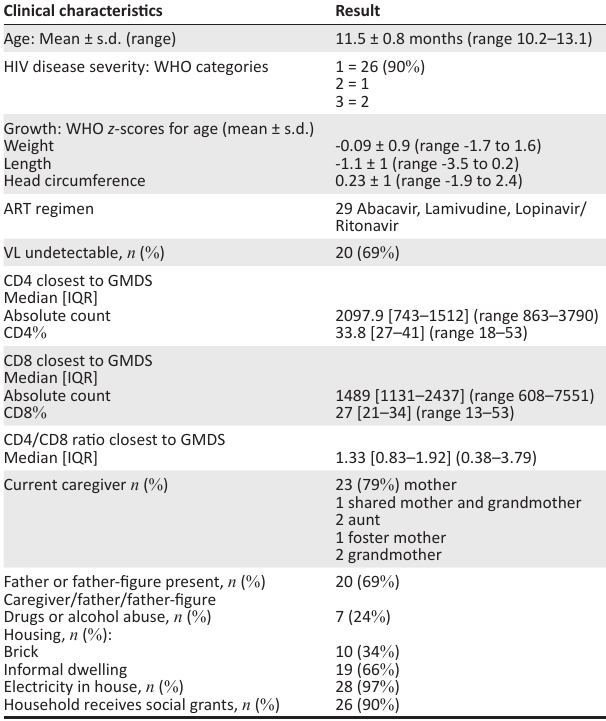
TABLE 3: Clinical status at the time of neurodevelopmental assessments ( N = 29).